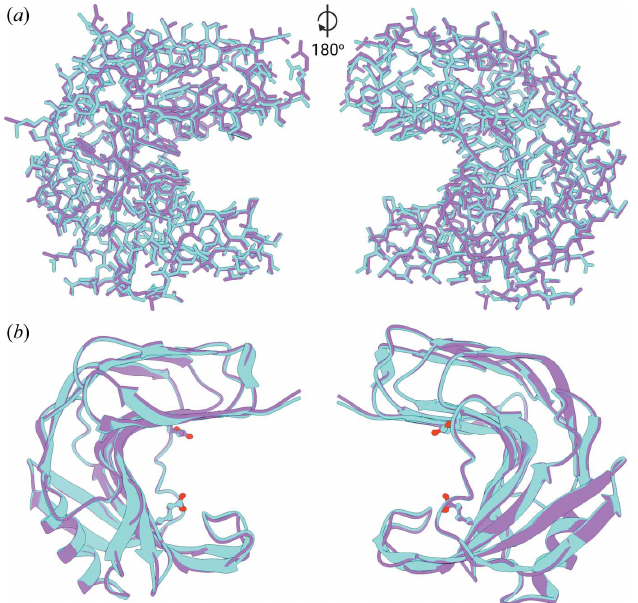
Figure 7 Comparison of the overall structures of NhGH11 xylanase obtained by cryoMX (cyan) and RT-SSX (magenta, 40000-image dataset). ( a ) All- atom ‘stick’ depiction of the proteins, allowing us to assess the alignment of the sidechains. ( b ) Cartoon-plot for better visibility of the overall fold and and residues E89 and E180 that form the catalytic center. These residues overlap almost perfectly for both datasets.